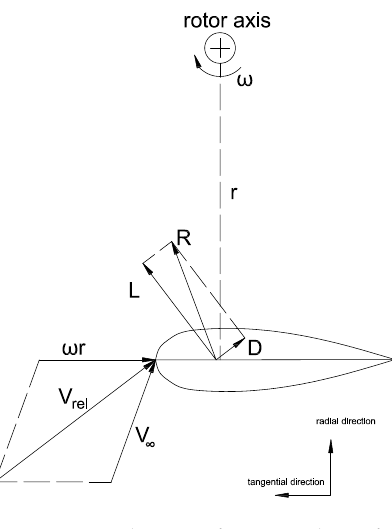
Figure 3. Aerodynamic forces on the